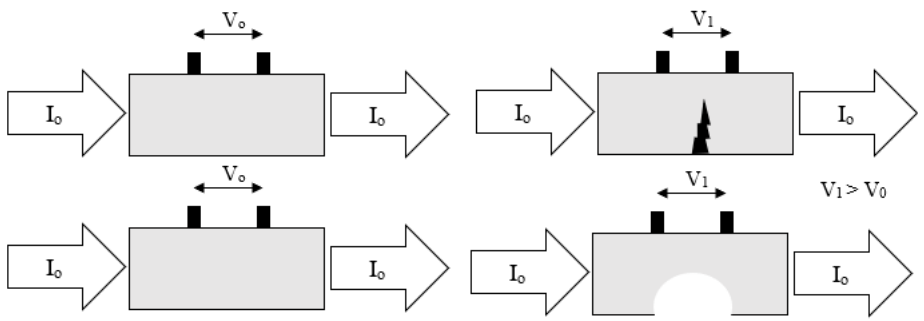
Figure 22. Basic principles of the FSM technique (Adapted with permission from ref. [88] Copyright 2011 Elsevier).